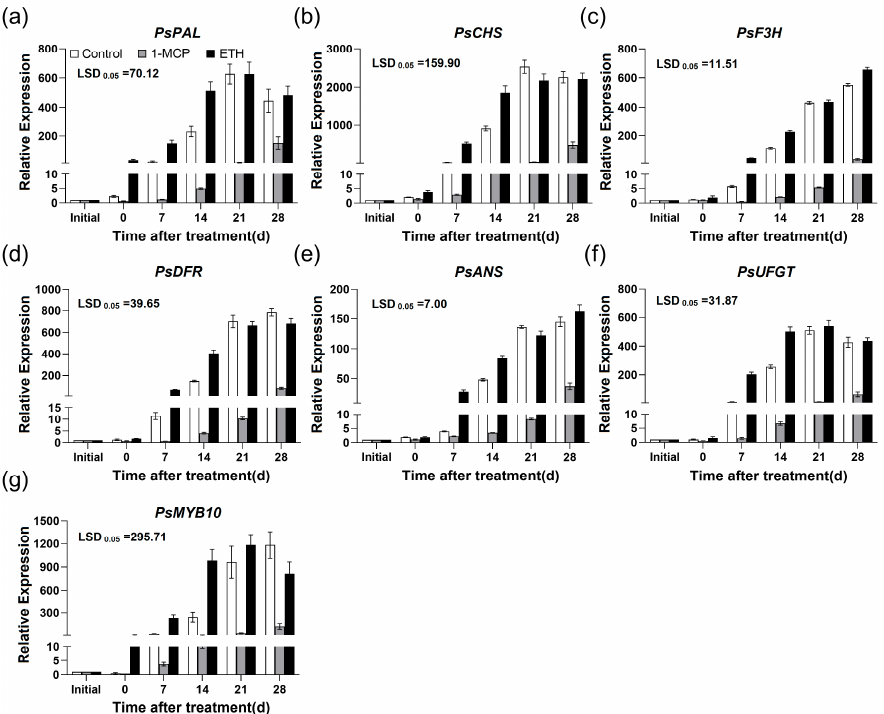
Figure 7. Effects of 1-MCP (1.0 μ L L − 1 ) and ETH (100.0 μ L L − 1 ) treatments on the expression profiles of genes associated with anthocyanin biosynthesis in ‘Friar’ plum fruit under 10 °C storage. ( a – g ) Relative expression of PsPAL , PsCHS , PsF3H , PsDFR , PsANS , PsUFGT and PsMYB10 . “Initial” represents the time point before ethylene and 1-MCP treatments. The vertical bar represents the standard error while the LSD values show significant differences at the 0.05 level. Plants 2023 , 12 , x FOR PEER REVIEW